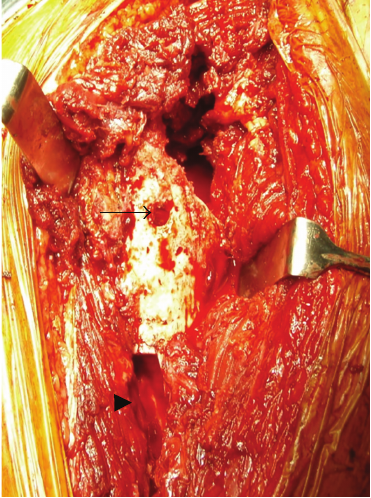
Figure 4: A bone hole at the lateral aspect of the greater trochanter (arrow) and a fenestration of the femur to remove the stem